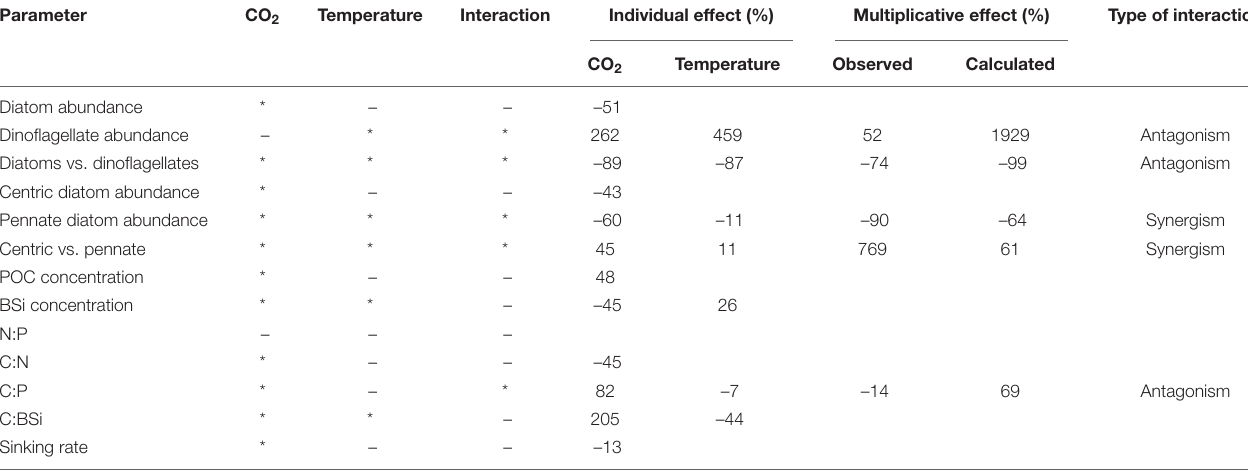
TABLE 2 | The individual and multiplicative effects of temperature and CO 2 and types of driver interactions on the parameters of the final sampling day of the experiment.